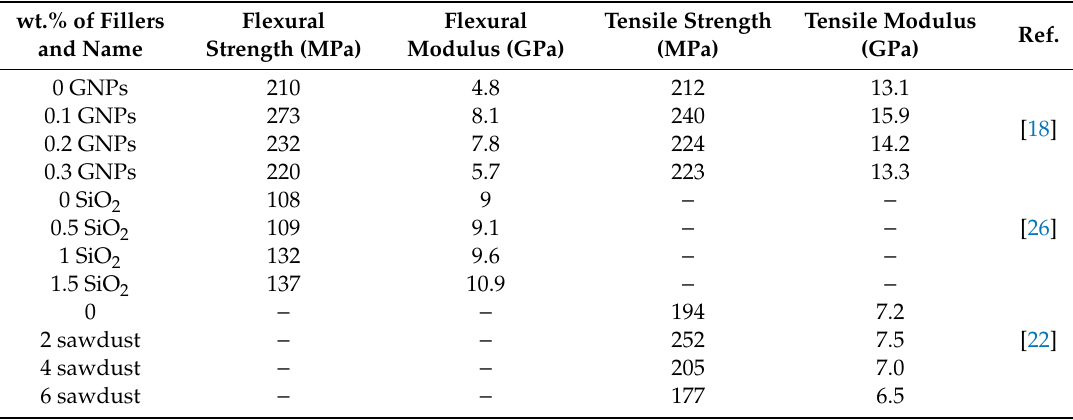
Table 3. Mechanical properties of basalt / epoxy composites with di ff erent filler.